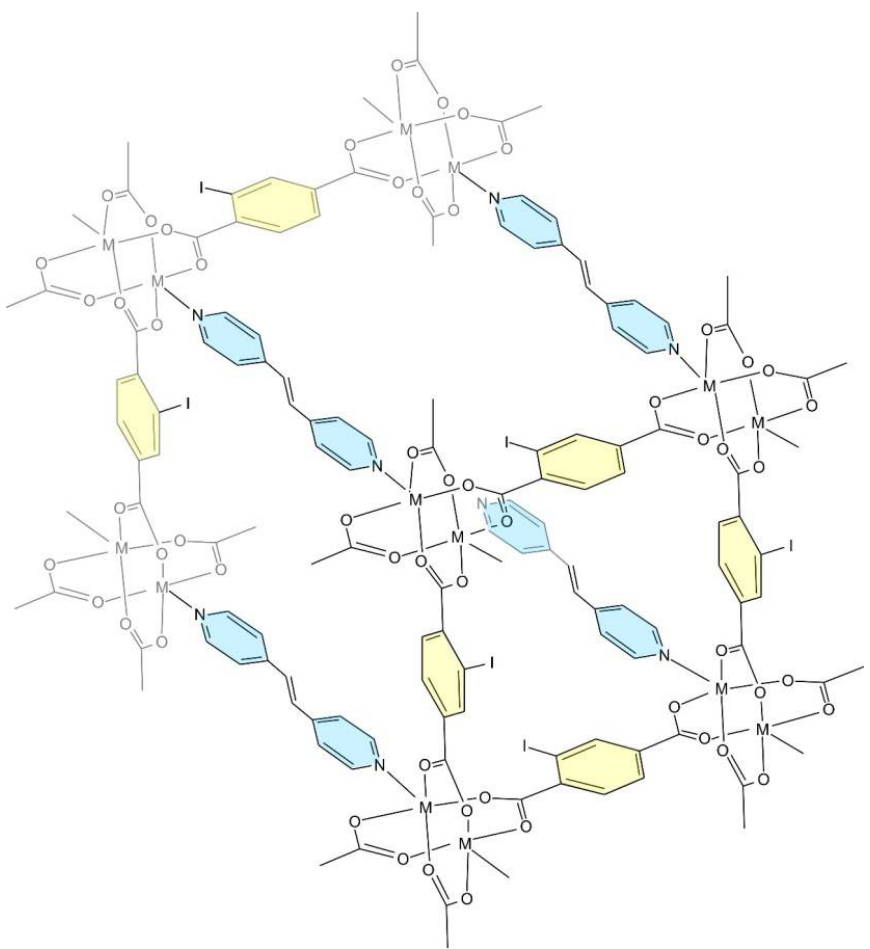
Figure 5. A fragment of the structures of the compounds in the example of 2 showing interpenetrated frameworks colored with blue and brown.